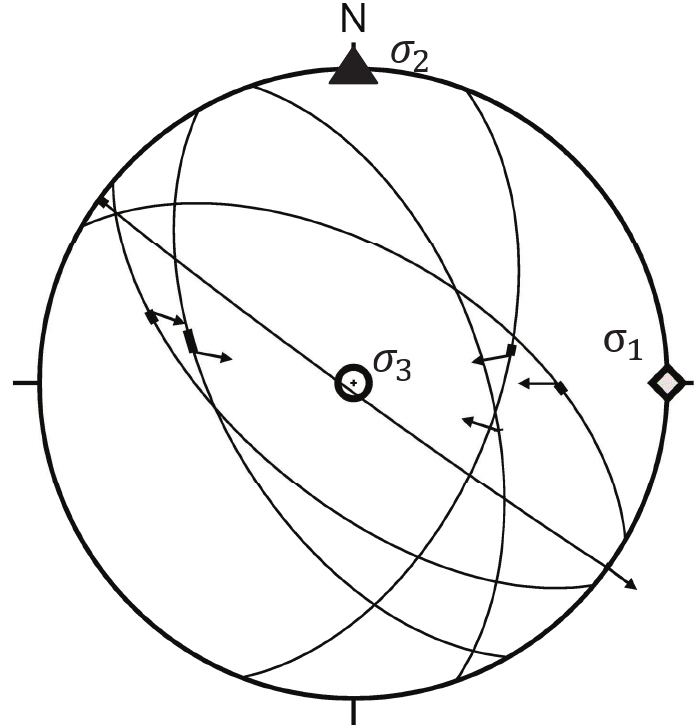
Figure 8 - Stress tensor inversion of the two Pantanal events and four Chaco Basin events. Maximum principal compression (σ ) is illustrated by the diamond, the circle is the minimum compression (σ 1 and the intermediate compression (σ ) is represented by the triangle. The arrows are the observed rake 2 and the thick line near the arrows represents the difference between the observed and calculated rake. Inversion shows compressional stress with E–W oriented (σ 1